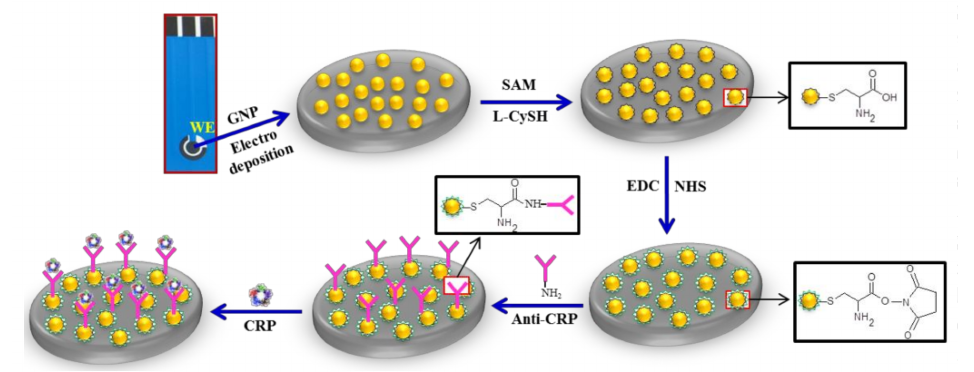
Figure 1. Schematic representation of the fabrication steps for the label-free C-reactive protein (CRP)